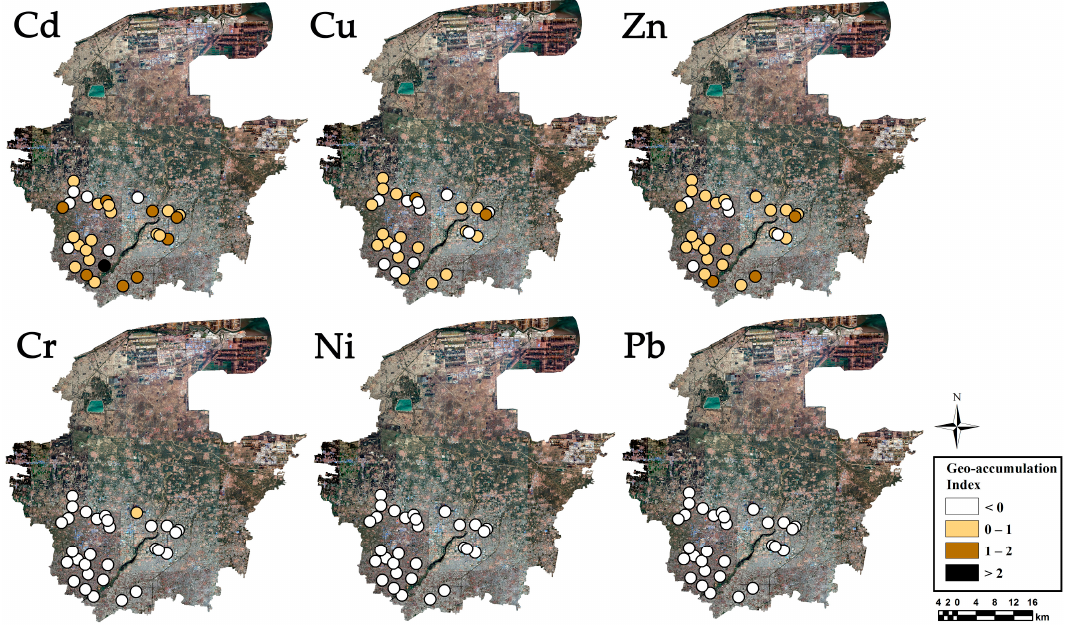
Figure 2. Spatial variations of I geo index for HMs in greenhouse soils in Shouguang.